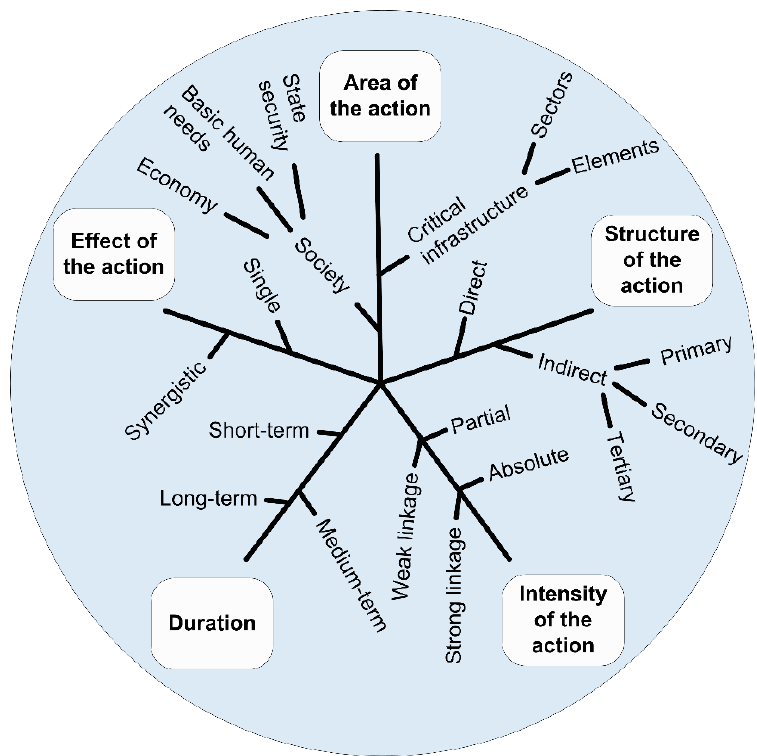
Figure 1. Aspects that create the impact character in a critical infrastructure system (Rehak et al. 2016).